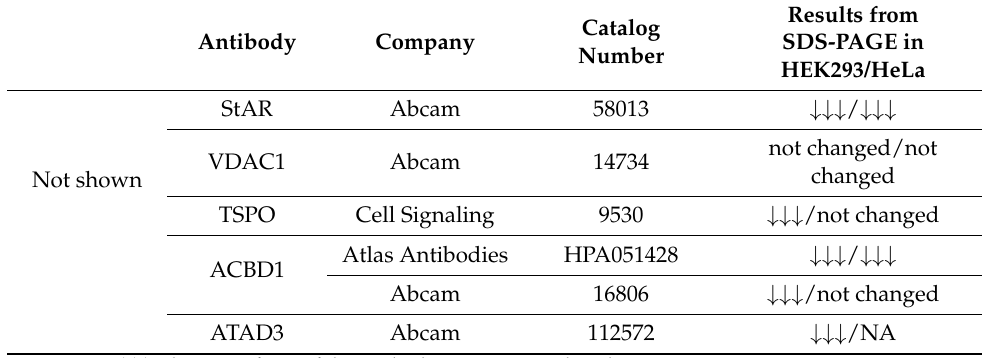
Table A4. Summary of antibodies used in experiments.